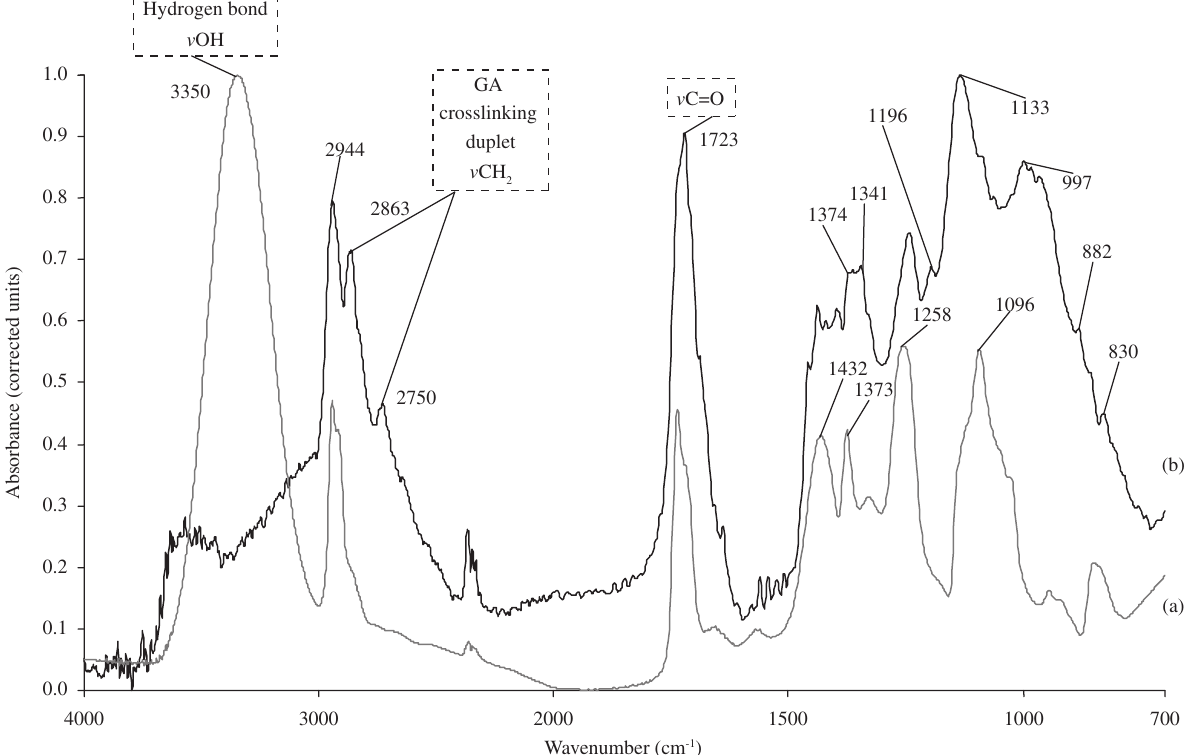
Figure 3. FTIR spectrum of PVA hydrogel a) pure PVA; and b) PVA hydrogel crosslinked with GA or PVA/